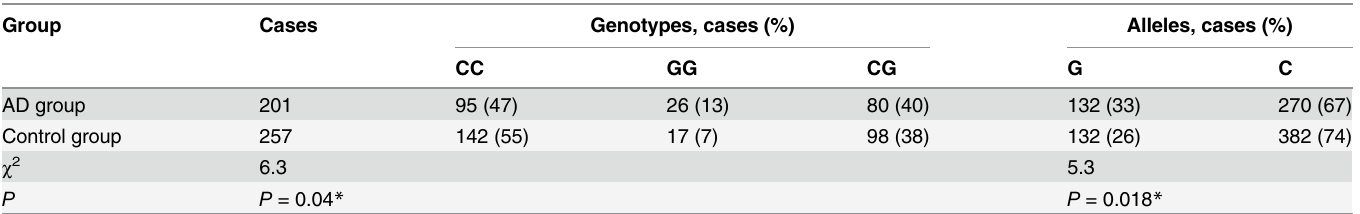
Table 4. Polymorphism distribution of rs266729.